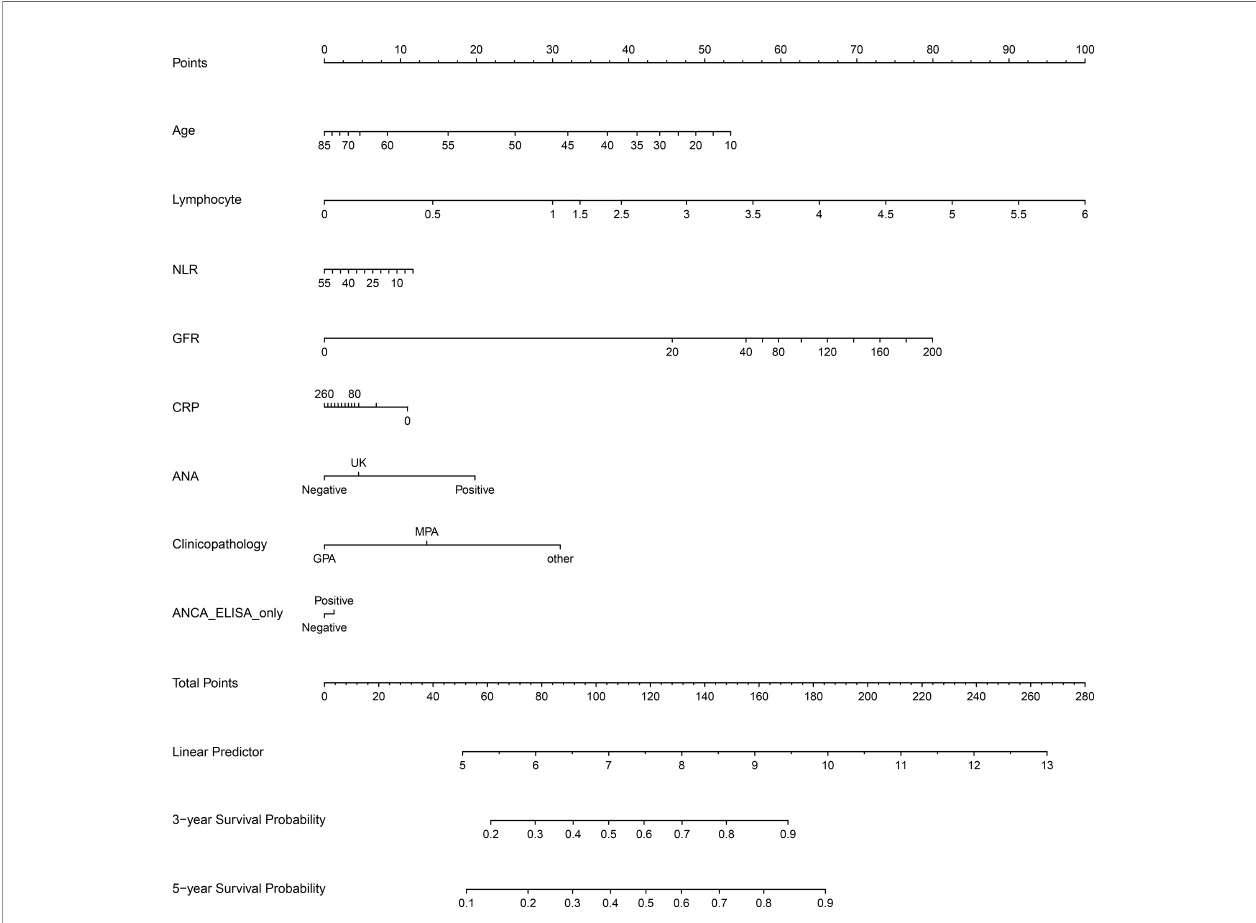
FIGURE 4 | The nomogram for 3-year and 5-year survival rates in patients with antineutrophil cytoplasmic antibody (ANCA)-associated vasculitis. NLR, neutrophil- to-lymphocyte ratio; GFR, glomerular fi ltration rate; CRP, C-reactive protein; ASO, anti-streptolysin O; ANA, antinuclear antibody; ANCA ELISA only, serum ANCA types (negative or positive for MPO and/or PR3) only classi fi ed using ELISA. MPO, myeloperoxidase; PR3, proteinase 3; UK, unknown, meaning that a clinical parameter was assigned to a score corresponding to “ UK ” when the clinical parameter was not